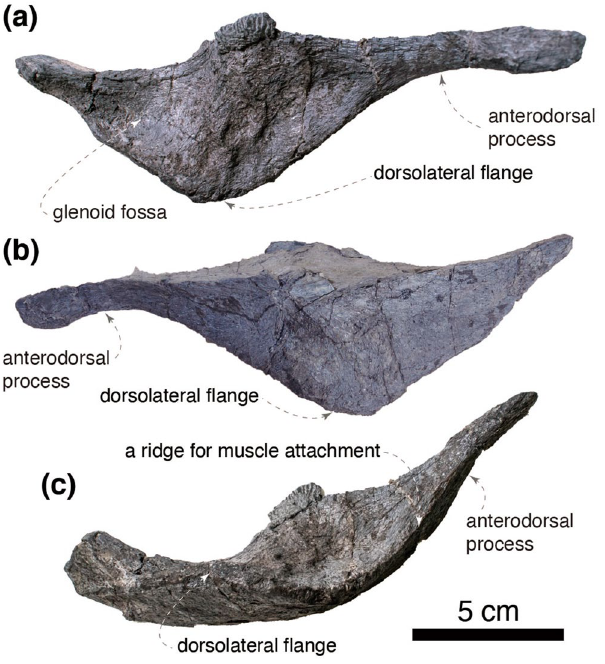
Figure 3. Right surangular of Yamatosaurus izanagii gen. et sp. nov. in dorsal ( a ), ventral ( b ), and lateral ( c ) including Olorotitan arharensis 38 and Parasaurolophus tubicen (NMMNH P-25100). The maximum mediolat- eral width of the dentary symphysial region in dorsal view is 81 mm, which is approximately twice as wide as the minimum breadth of the dentary posterior to the dentary symphysial region (Fig. 2c). In dorsal view, the symphysis is largely divergent from the lateral surface of the main body of the dentary by an angle of 20 degrees as in Eotrachodon orientalis 39 but unlike a nearly parallel alignment in hadrosaurids such as Edmontosaurus regalis 40 and Parasaurolophus tubicen (NMMNH P-25100). The symphysis bears a shallow horizontal groove for contact with its counterpart (Fig. 2b). The ventral surface of the symphysial process has a large neurovascular foramen (Fig. 2d). The base of the coronoid process is laterally expanded as in hadrosaurids and some non-hadrosaurid had- rosauroids such as Plesiohadros djadokhtaensis , Nanningosaurus dashiensis , and Adynomosaurus arcanus 41–43 and is separated from the dental battery (Fig. 2e). The posteromedial surface of the coronoid process is largely excavated, forming the mandibular adductor fossa. The dorsolateral portion of the right surangular is preserved (Fig. 3). The preserved region of the anterodorsal process is thin and bears a well-defined ridge for the attachment of m. adductor mandibulae externus superficia- lis 44 . The ridge is posteriorly continuous with the dorsolateral flange, which is gently arcuate in dorsal view. The lateroventral surface of the surangular bears no foramen as in derived hadrosauroids including Bactrosaurus johnsoni 45,46 . The dorsal surface of the anterior half of the surangular is concave to form the mandibular adductor fossa, whereas the posterior half forms a glenoid fossa that receives the mandibular condyles of the quadrate. The ventromedial portion of the surangular is lost before collection thus the morphology of the caudal process and the retroarticular process is unavailable. At least 34 tooth positions are present, and each tooth position bears a maximum of four teeth in the right dentary, and at least twelve isolated dentary teeth from the left side are preserved. Tooth crowns are diamond- shaped and bear a prominent straight primary ridge in the middle teeth, while the primary ridge is sinuous in mesial and distal teeth (Figs. 2b, 4a,h). The secondary ridges are faint, wrinkled, and in some cases branched as in Eotrachodon orientalis 39 and Hypacrosaurus altispinus 47 but unlike the straight secondary ridges of Corytho- saurus casuarius (ROM 868) and Lambeosaurus lambei (CMN 361, CMN 2869). The largest tooth crown, located in the middle portion of the dental battery, is approximately 41.94 mm high and 14.66 mm wide. The tooth crowns become shorter and narrower mesially and distally (Fig. 2b). The height/width ratios of the dentary tooth crowns are slightly less than three on average although vary largely by position. The marginal denticles along the mesial and distal edges of the coronal half of the tooth crown are proportionately smaller than those of Eotrachodon orientalis 39 and Lambeosaurus lambei (CMN 351) and resemble those of Hypacrosaurus altispi- nus in size 47 . The marginal denticles of Yamatosaurus izanagii are formed of multiple small papillae (Fig. 4b,c), which are unorganized unlike in Eotrachodon orientalis 39 and Corythosaurus casuarius (AMNH FARB 8527), but resembling Gryposaurus notabilis (AMNH FARB 8526). The angle between the crown and root of the dentary teeth is 132 degrees (Fig. 4b).